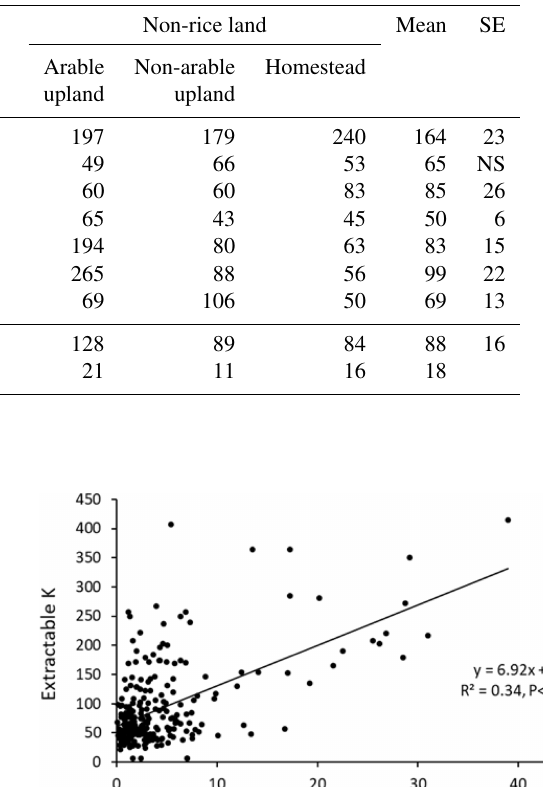
Figure 4. The relationship between cation exchange capacity and organic carbon and pH in soils across seven EIP watersheds. Table 5. Extractable K (mgkg − 1 ) in seven EIP watersheds.